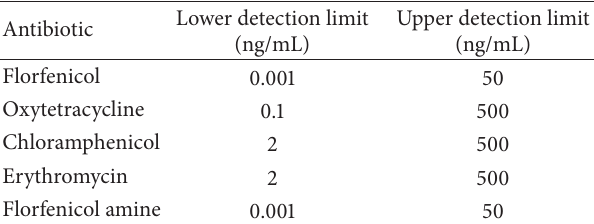
Table 2: Detection limits for each antibiotic by SRM.